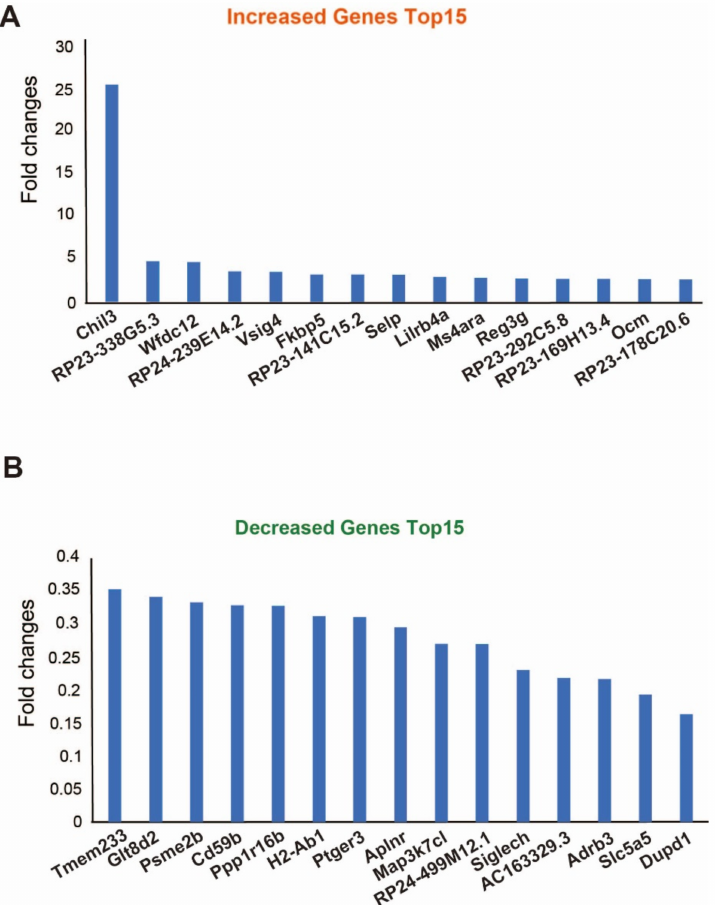
Figure 2. Selected genes with significant expression change in the thyroid gland tissue of BDL mouse models. ( A , B ) The common genes with a significant expression change in the thyroid gland tissue in BDL models. The graphs depict ( A ) the top 15 genes with increased expression and ( B ) the top 15 genes with decreased